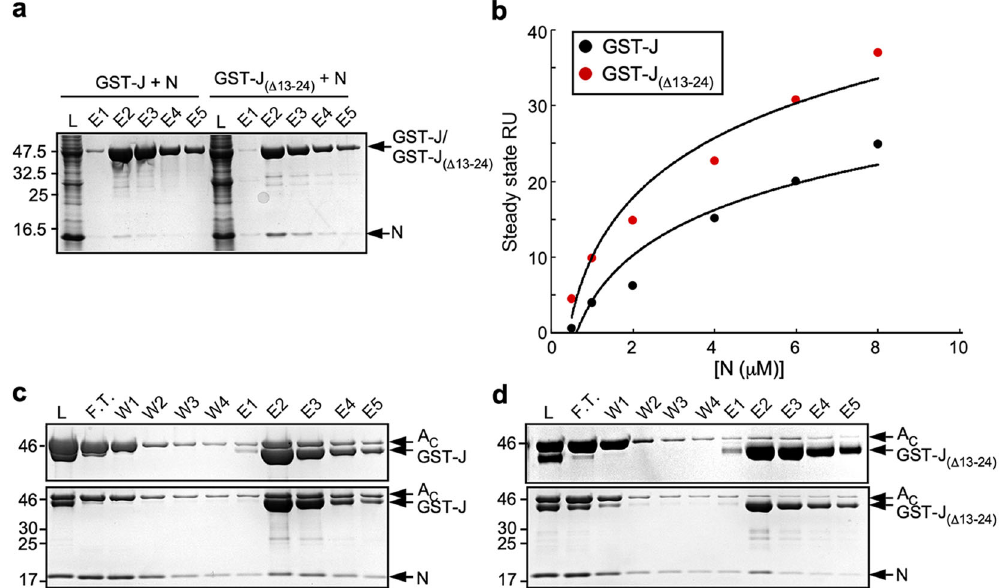
Fig. 5 Effect of a deletion of residues 13 – 24 of FliJ on interactions of FliJ with FlgN and FlhA C . a Interaction between FliJ and FlgN. Cell lysates prepared from Salmonella SJW1368 ( Δ fl hDC-cheW ) cells expressing either GST-FliJ (indicated as GST-J) or GST-FliJ( Δ 13 – 24) (indicated as GST-J ( Δ 13 – 24) ) were mixed with those from E. coli BL21(DE3) Star cells producing His-FlgN (indicated as N), and then each mixture (indicates as L) was loaded onto a GST column. After extensive washing, proteins were eluted with a buffer containing 10 mM reduced glutathione. Eluted fractions were analyzed by SDS-PAGE with CBB staining. The regions of interest were cropped from original CBB-stained gels shown in Supplementary Fig. 13a. b Measurements of the binding af fi nities of FliJ and FliJ( Δ 13 – 24) for FlgN by SPR. His-FlgN of various concentrations was fl owed over the sensor surface with immobilized GST-FliJ or GST- FliJ( Δ 13 – 24) in 10 mM HEPES pH 7.4, 0.15 M NaCl, 3 mM EDTA, 0.005% Surfactant P20 at a fl ow rate of 20 μ l min − 1 . All experiments were performed at 25 °C. The steady-state resonance units (RU) were plotted against FlgN concentrations. c , d Effect of FlgN on the FliJ-FlhA interaction. Puri fi ed His-FlhA C was mixed with puri fi ed c GST-FliJ or d GST-FliJ( Δ 13 – 24) in the absence (upper panel) and presence (lower panel) of puri fi ed His-FlgN, and dialyzed overnight against PBS. Each mixture (L) was loaded onto a GST column. After washing with 10 ml PBS at a fl ow rate of about 0.5 ml min − 1 , proteins were eluted with 10 mM reduced glutathione. Flow through fraction (F.T.), wash fractions (W), and elution fractions (E) were analyzed by SDS-PAGE with CBB staining. The regions of interest were cropped from original CBB-stained gels shown in Supplementary Fig. 13b.